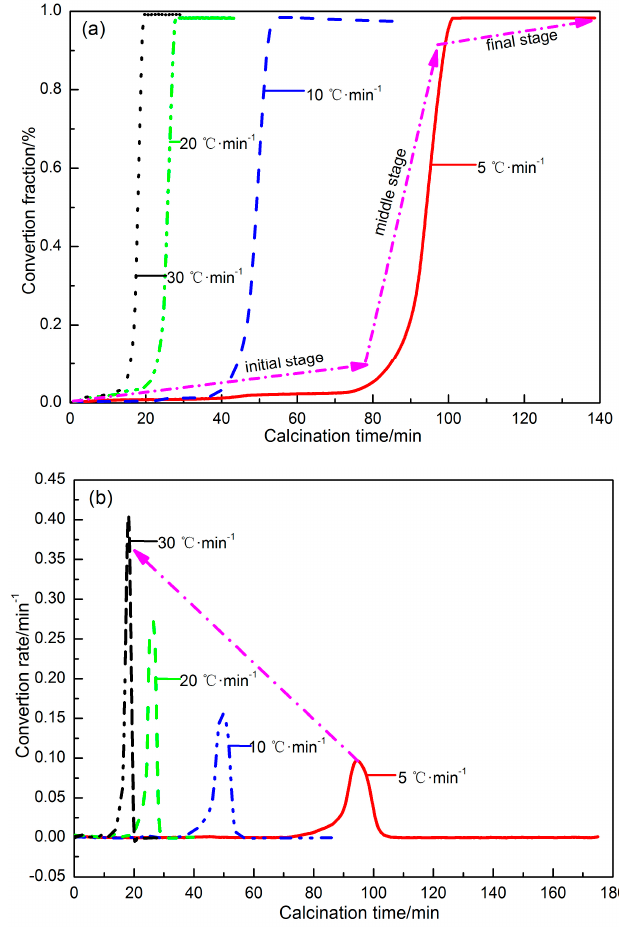
Figure 4. The conversion fraction ( a ) and conversion rate ( b ) profiles of siderite pyrolysis at different heating rates.